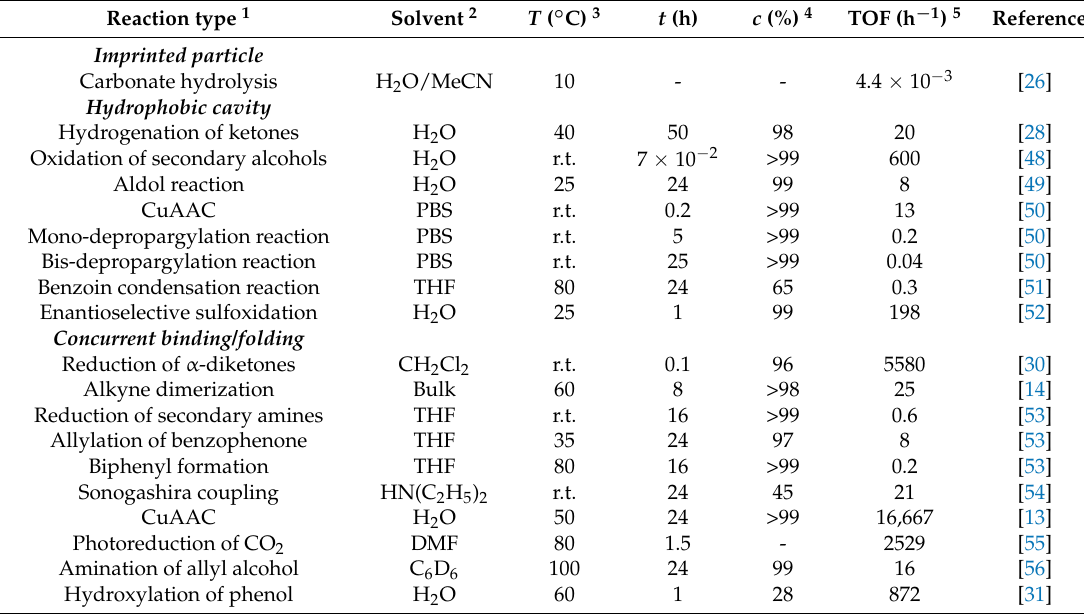
Table 3. Summary of reactions catalyzed by unimolecular particles as bioinspired nanoreactors organized by the different strategies followed to endow them with enzyme-mimetic